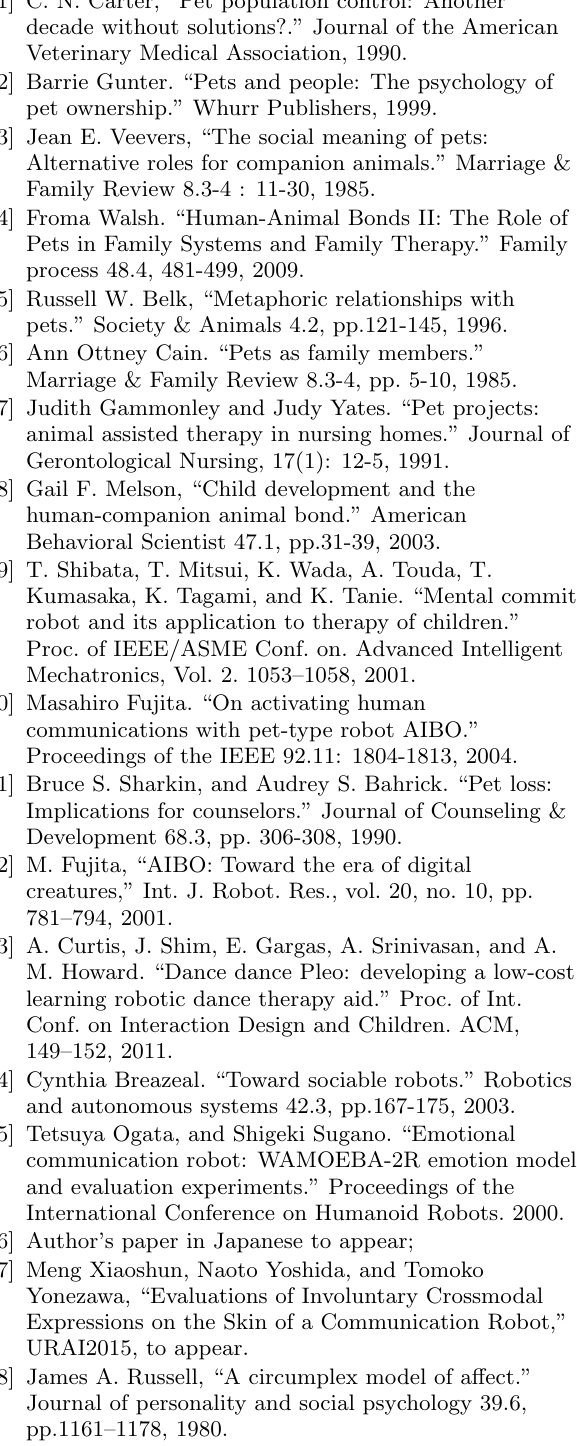
Table 2: ANOVA results factor expression